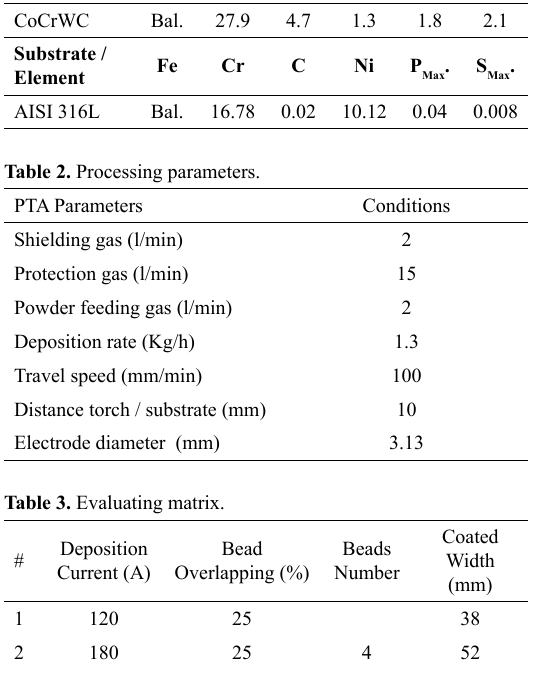
Figure 3. Tensile specimen dimensions (mm) 22